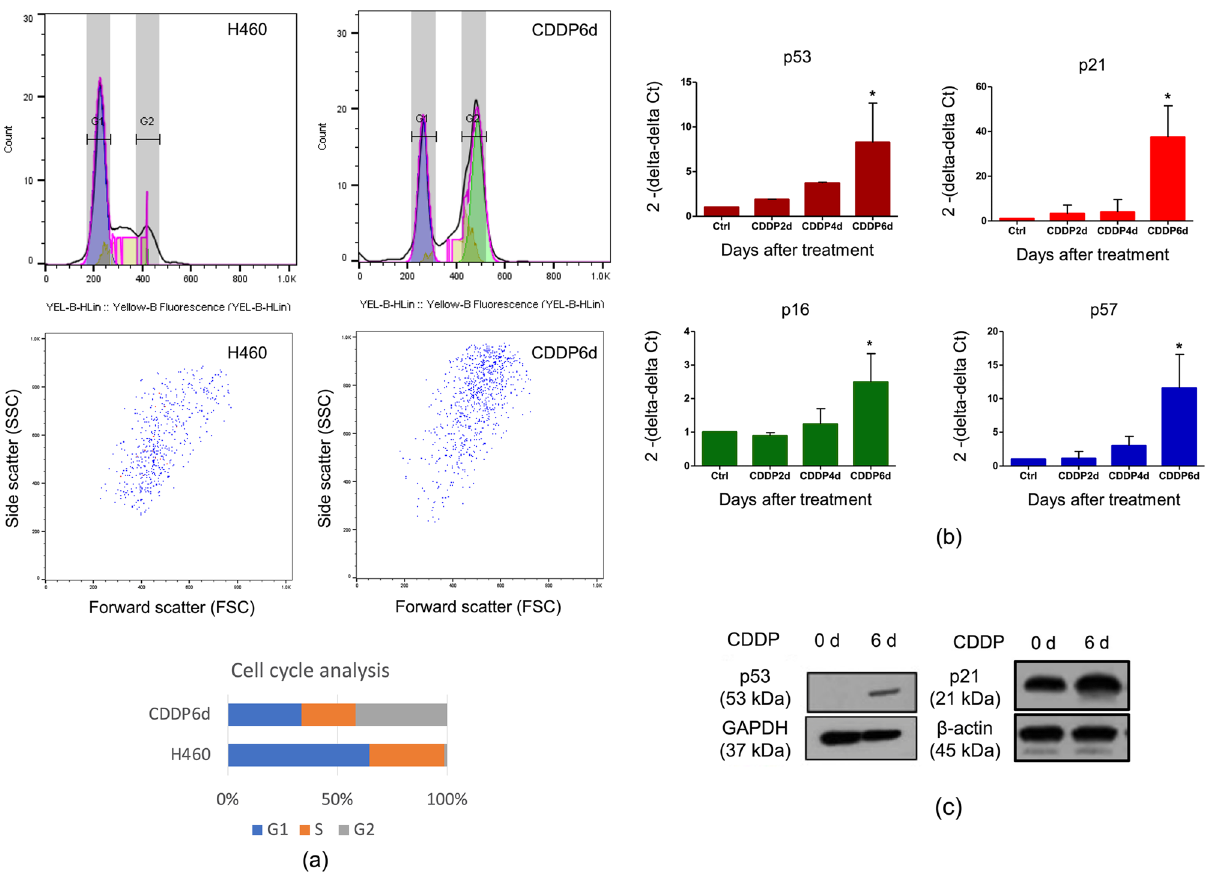
Figure 2. CDDP-induced H460 senescence cell through DNA damage response via p53/p21 pathway. ( a ) Cell cycle analysis after 6 days of treatment of 5 µM CDDP in H460 cells by flow cytometry ( b ) Time-course analysis of the relative mRNA levels of p53, p21, p16 and p57 by real-time Q-PCR in H460 cells treated with CDDP at 5 µM. ( c ) p53, p21 Western blot analysis of CDDP induced H460 senescence cells (the full-length blots are presented in Supplementary Figures). For all the data, the average of three independent experiments is shown. Data was analyzed by two-tailed Student’s t-test. *Denotes p <